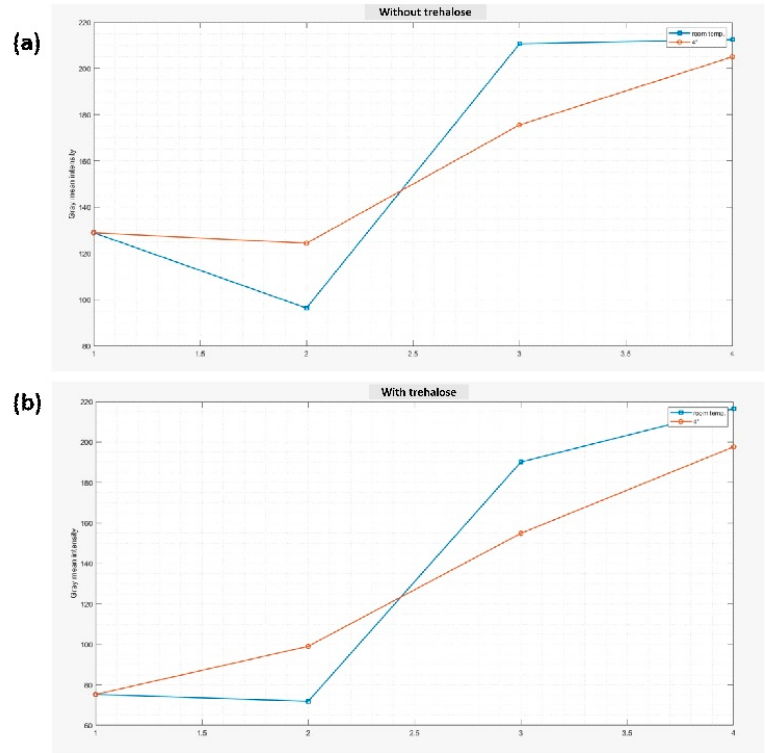
Figure 14. Graph showing the mean gray values for the set ( a ) in which trehalose was added ( b ) in which trehalose was not added and kept at room temperature and 4 °C.